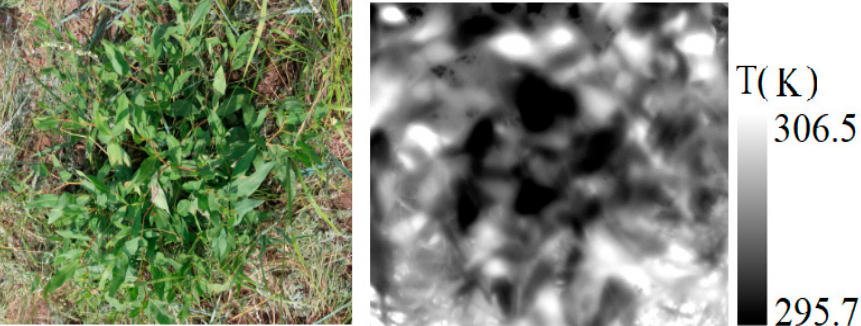
Figure 21. Temperature of Polygonum divaricatum.